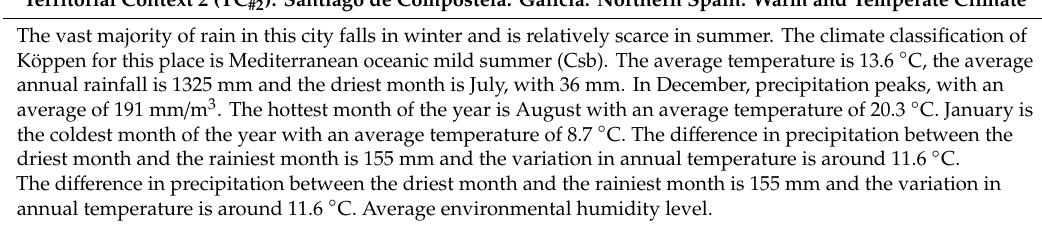
Table 2. Description of Territorial Context 2.